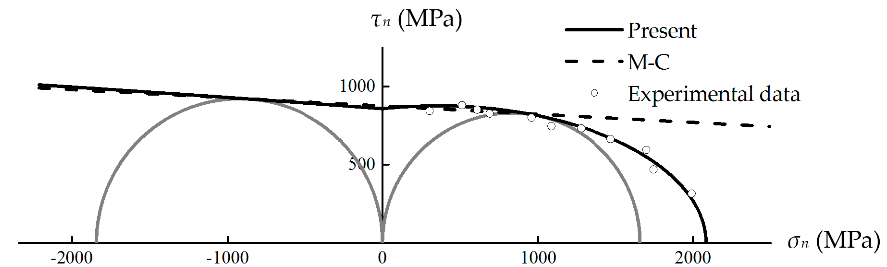
Figure 9. Failure envelopes and the experimental data of metallic glass [7]. T = 1660 MPa, C = 1843 MPa, θ T = 50.7°, and θ C = 43.0°.